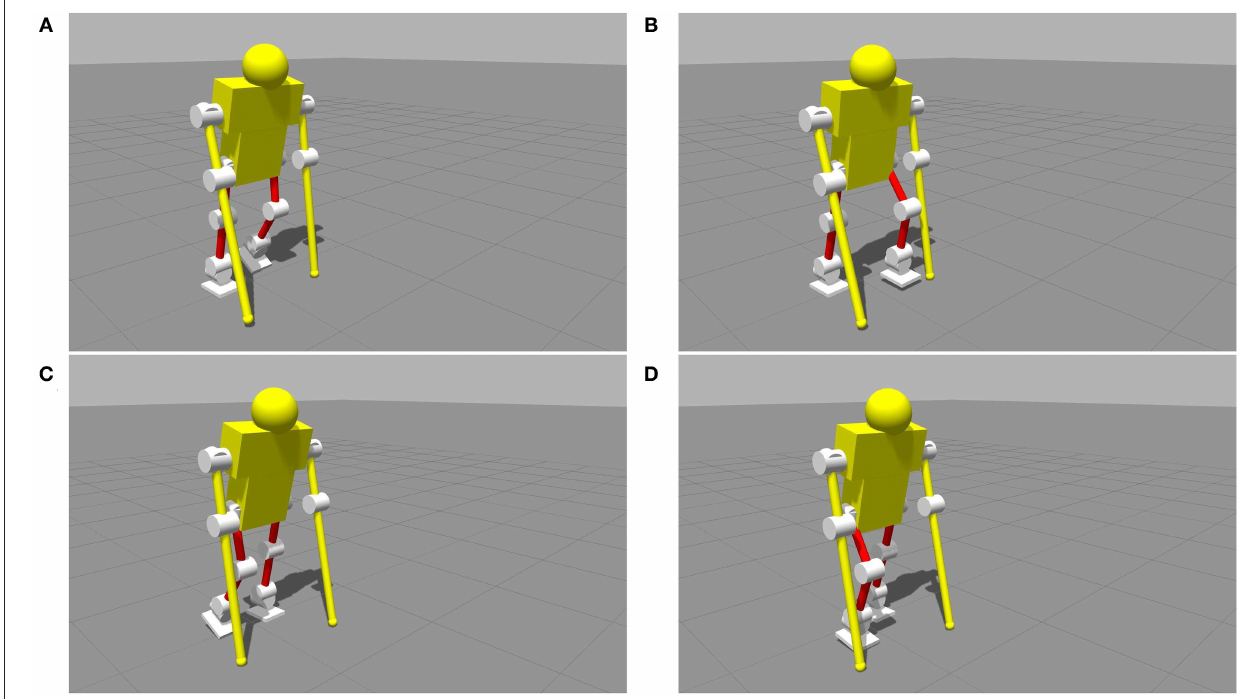
FIGURE 7 | The simulation of a smooth walk with the linear inverted pendulum (LIP) method. These figures represent a complete gait cycle, starting from the left foot to the right foot, shown in (A–D) in turn.